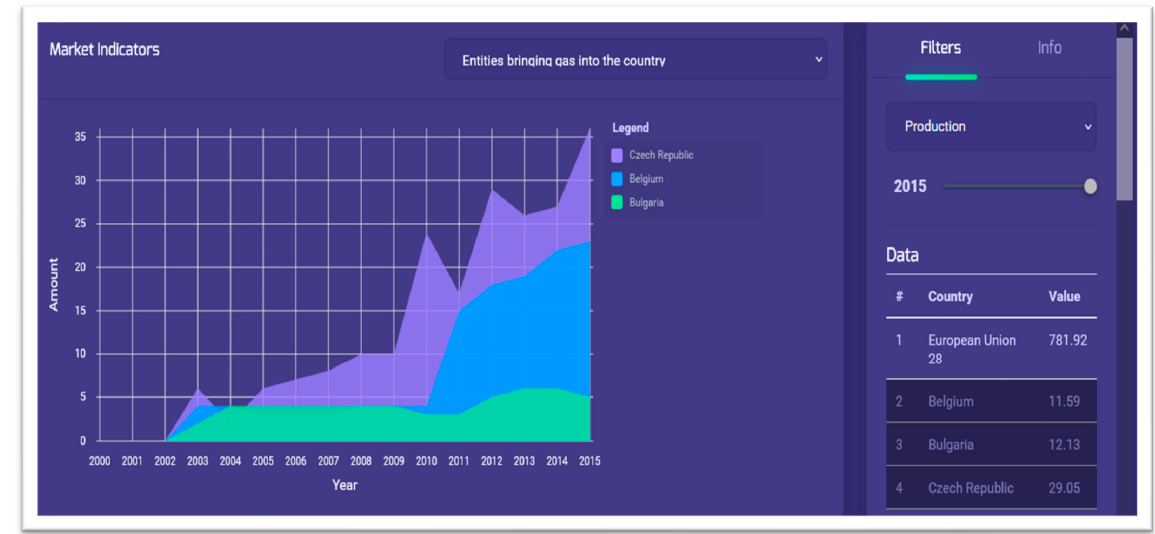
Figure 9. Comparison of market indicators—entities bringing gas into EU countries. Similar to the EU Energy Targets page, there is a time series chart of a selected country for a selected indicator with the forecasts of the indicator’s values along with its confidence intervals. The treemap is used to display data that is nested in a hierarchical structure and can capture relative sizes of indicator subcategories, showing factors that are large contributors to each category. Color can identify factors that are under- or over-performing compared to other factors from the same category (Figure 10).